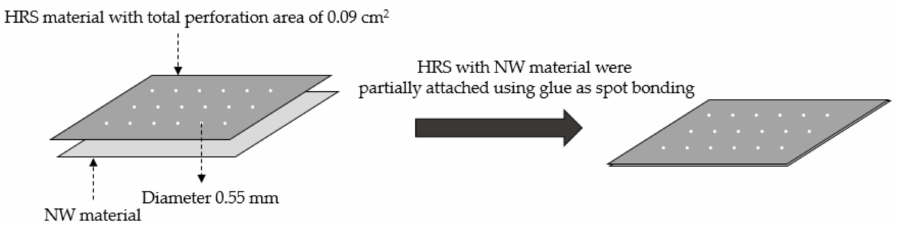
Figure 2. Function design of the combination between HRS and NW